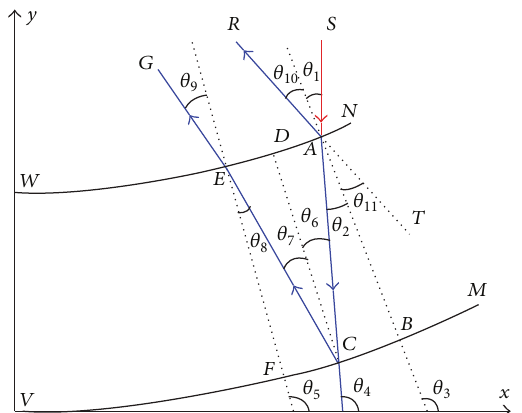
Figure 1: The main path of sunlight arriving at the concentrating